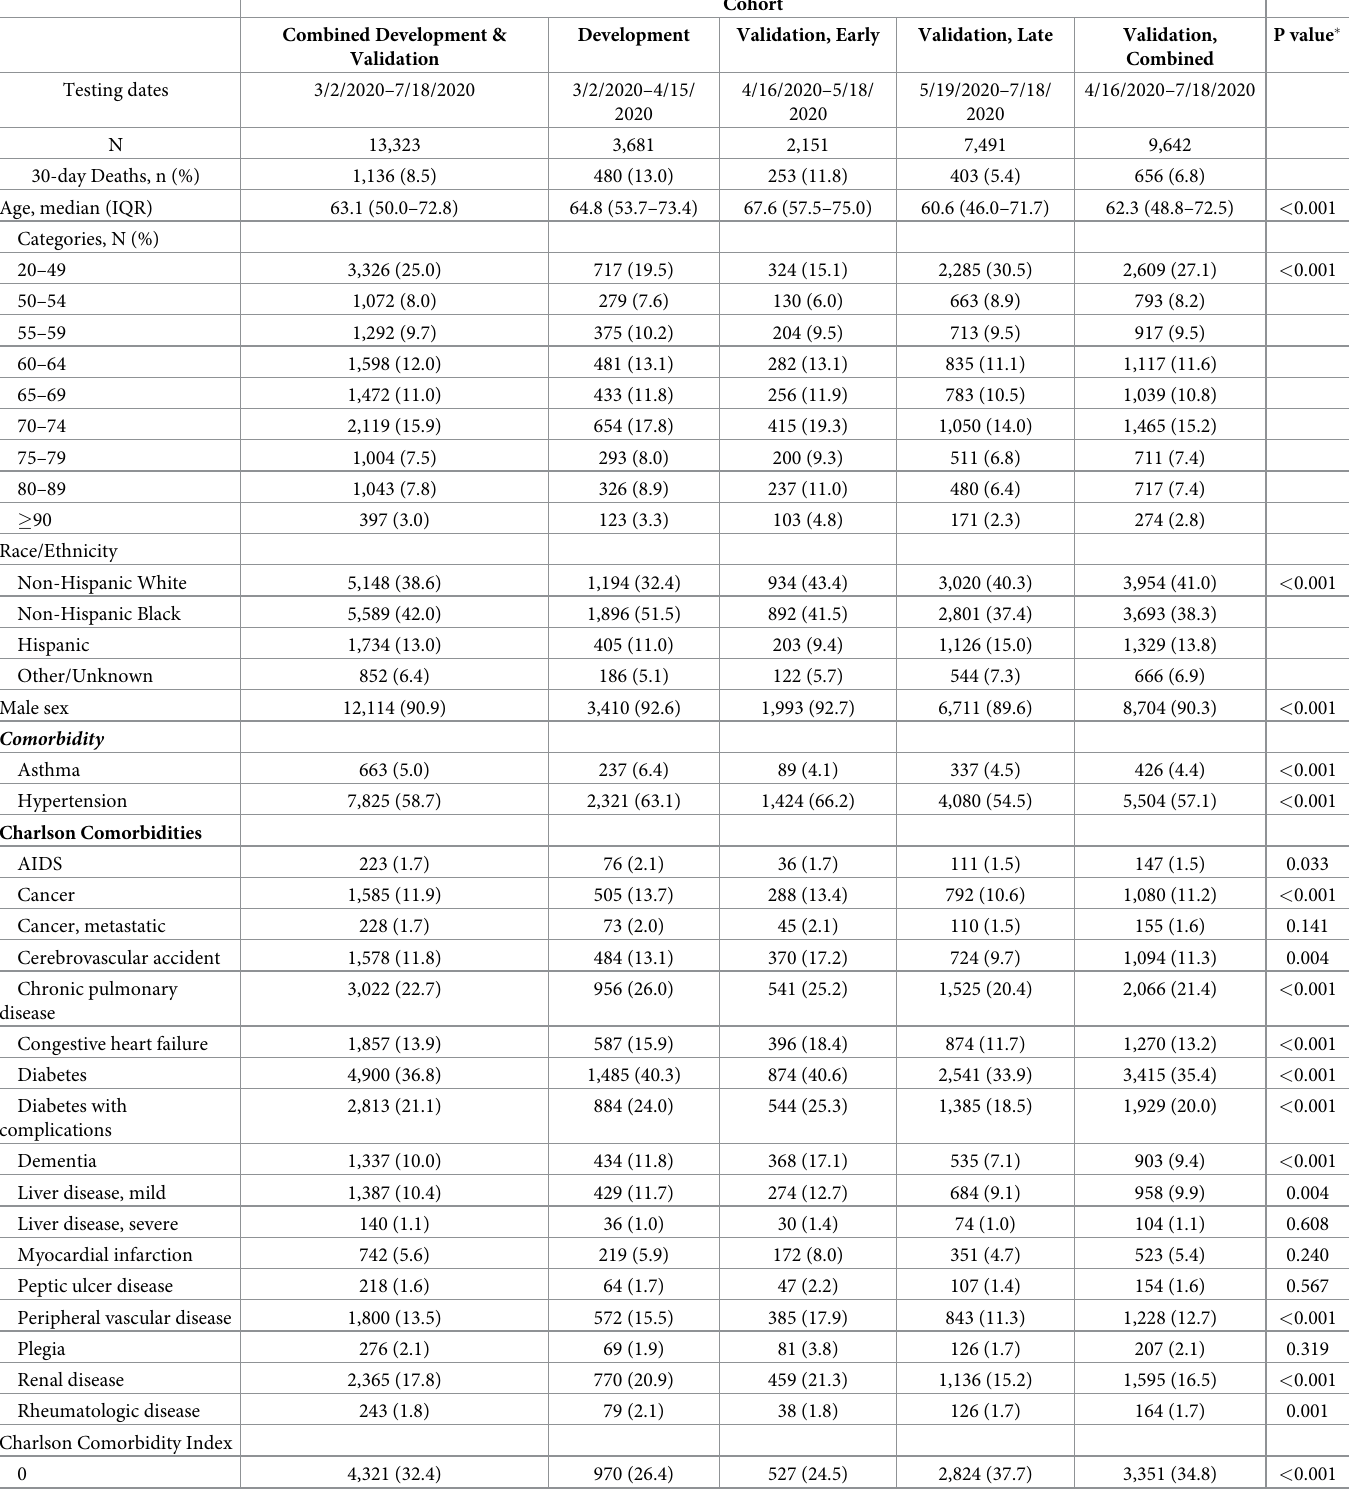
Table 1. Characteristics of patients in VACO Index development and validation